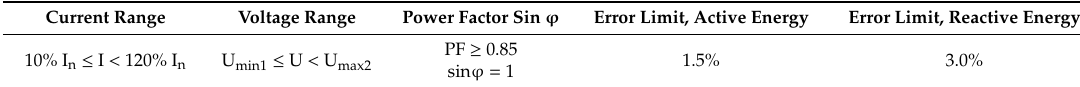
Table 4. EMS error limits according to EN 50463-2 [4].